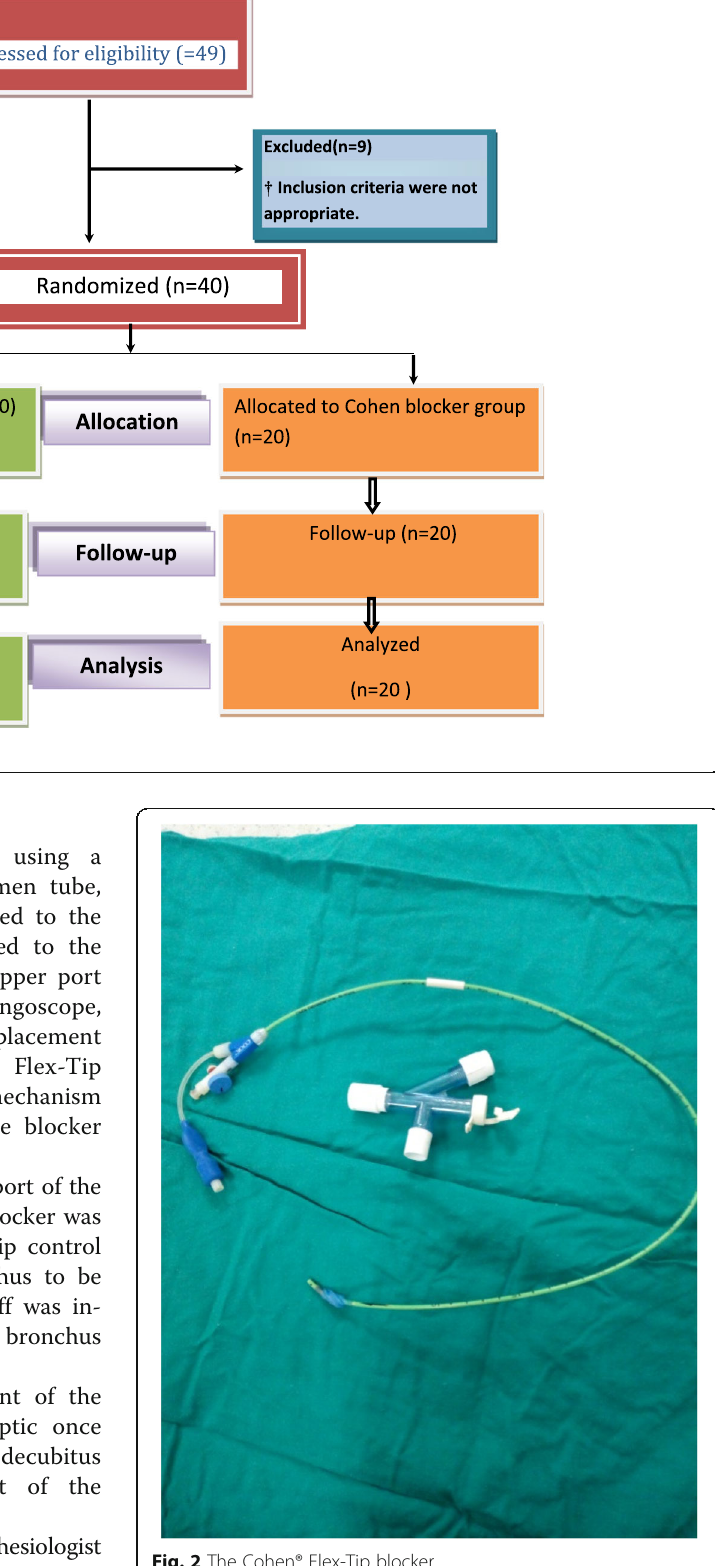
Fig. 2 The Cohen® Flex-Tip